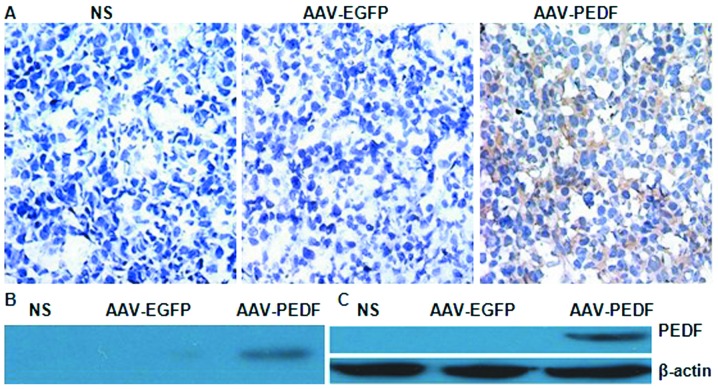
PEDF gene expression in vivo and in vitro. Mice were euthanized on day 15 post-treatment and (A) tumours were processed for immunohistochemistry analysis (original magnification, ×400). Only the cytoplasm of LLC cells treated with AAV-PEDF was stained for intratumoural PEDF. (B) PEDF protein (50 kDa) was detected in AAV-PEDF, but not AAV-EGFP or normal-saline (NS)-treated LLC tumours. (C) Human PEDF was detected as a single band of 50 kDa in AAV-PEDF-infected cells, but not in AAV-EGFP-infected or NS-treated cells.